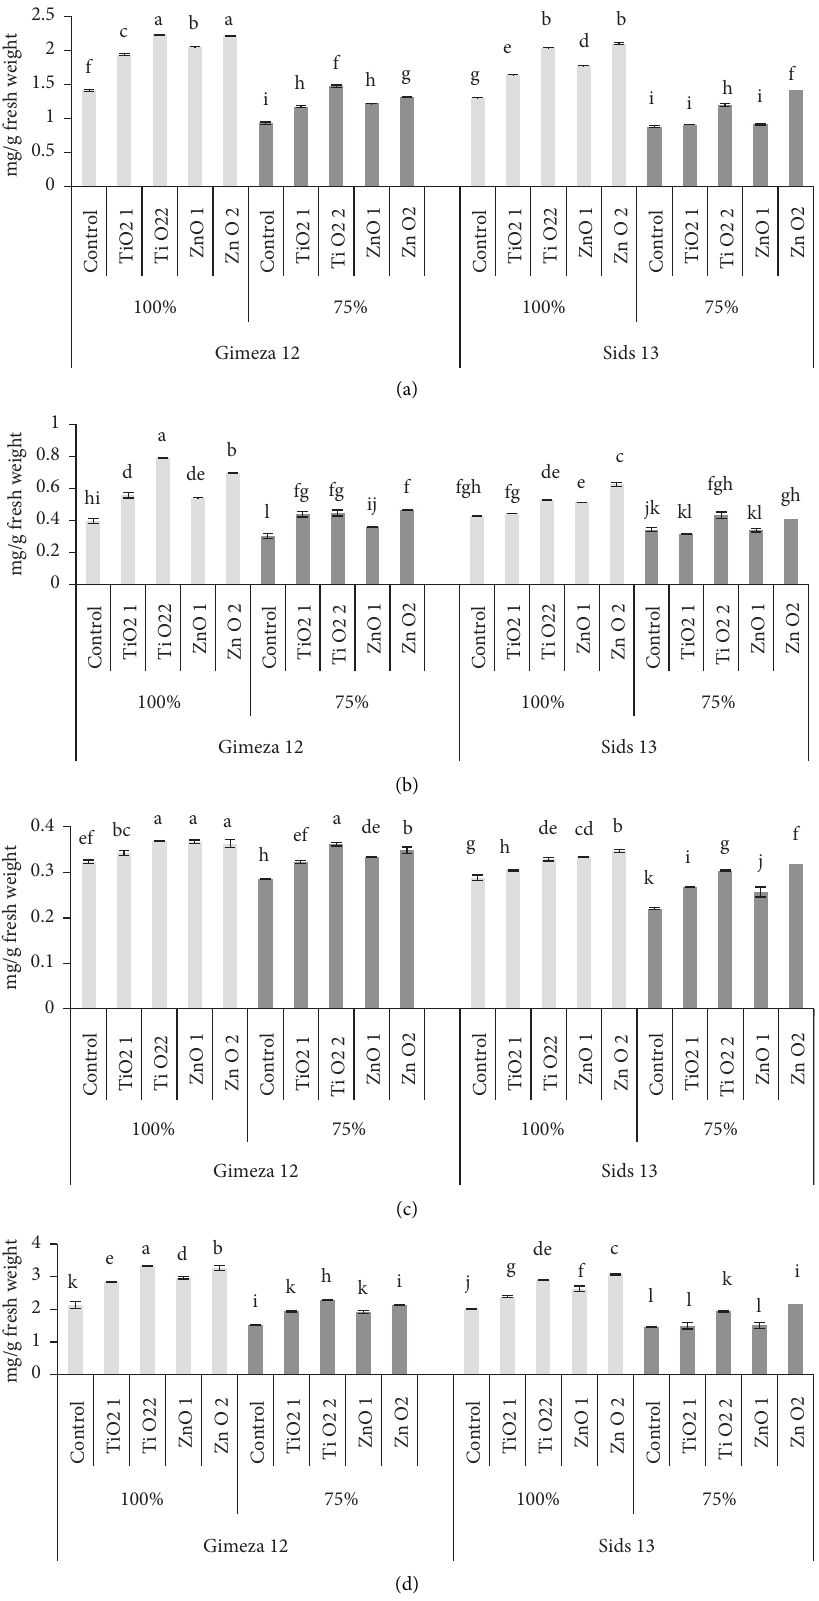
Figure 4: The effect of different concentrations of nano-TiO 2 or nano-ZnO (5 and 10mg/L) on chlorophyll a (a), chlorophyll b (b), carotenoids (c), and total pigments (d) of both wheat cultivars (Gimeza 12 and Sids 13) subjected to different levels of water irrigation requirement at 75 days from sowing. TiO 2 1 � 5mg/L, TiO 2 2 � 10 mg/L, ZnO 1 � 5mg/L, and ZnO 2 � 10